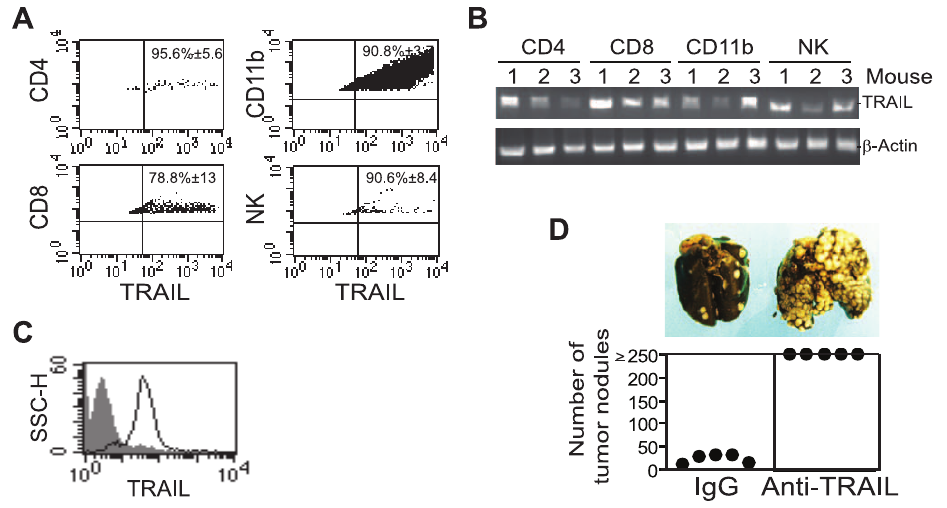
Figure 5. TRAIL expression and function in tumor-infiltrating immune cells. A. Tumor-bearing lungs were excised approximately 21 days after tumor cell injection and analyzed by flow cytometry. The percentage of CD4 + T cells, CD8 + T cells, CD11b + macrophages and NK cells in the tumor population were gated for TRAIL expression analysis. The percentage of TRAIL-positive cells in each subset of immune cells as shown in A were quantified and expressed as mean 6 SD. B . TRAIL mRNA level in tumor-infiltrating immune cells. CD4 + T cells, CD8 + T cells, CD11b + macrophage and NK cells were purified fromthe single cell suspension using cell type-specific mAb and magnet beads and analyzed for TRAIL transcript level by RT-PCR. Data from three mice are shown. C . Cell surface TRAIL protein level in tumor-specific CTLs. CTLs were stained with fluorescent dye-conjugated anti-TRAIL mAb and analyzed byflow cytometry. Isotype-matchedIgG control stainingisdepicted asgray area,and TRAIL-specific stainingisdepicted assolid line. D . Function of TRAIL in suppression of colon carcinoma. CT26 cells (5 6 10 4 cells/mouse) were mixed with IgG and anti-TRAIL neutralizing mAbs (50 m g/mouse), respectively, and injected into mice i.v. Two days later, IgG or anti-TRAIL mAb (100 m g/mouse) were injected into mice again. Mice were sacrificed 14 days after tumor transplantation and analyzed for lung metastasis. Images of lungs from representative mice are shown (top panel). The number of lung tumor nodules was enumerated in a single-blinded fashion. Each dot represents total counts from independent mice (bottom panel). Counts greater than 250 are expressed as $ 250. The difference between the IgG control and the anti-TRAIL mAb treatment group is statistically significant ( p , 0.01).